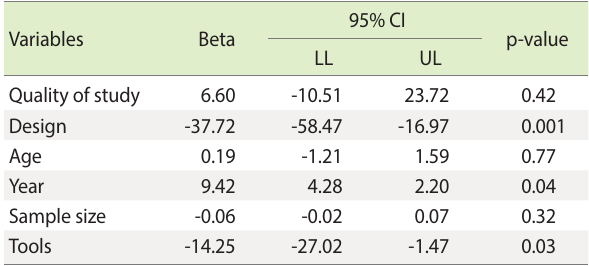
Table 2. Heterogeneity among the selected studies based on meta-